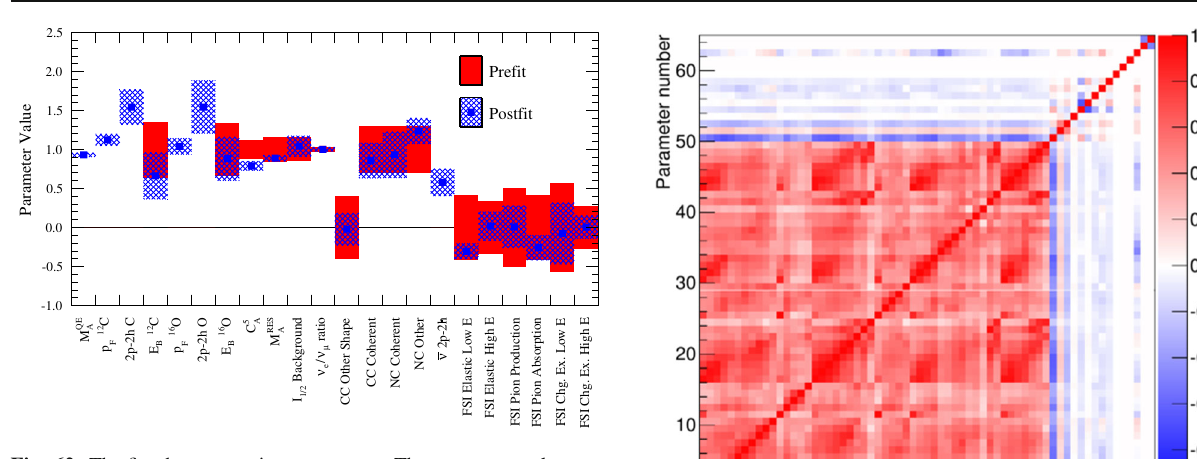
Fig. 62 The fitted cross-section parameters. The parameter values are either 1 or 0 in the default models in the simulation